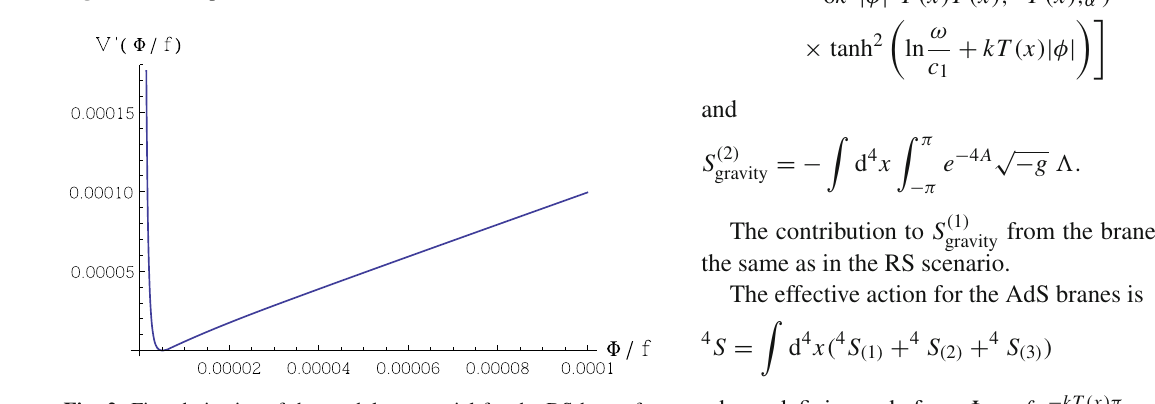
Fig. 2 First derivative of the modular potential for the DS brane for ω = 10 −